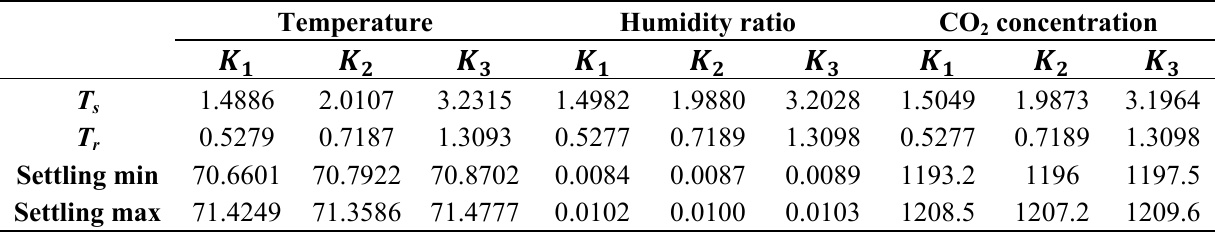
Table 5. Control performance metrics of the LQR